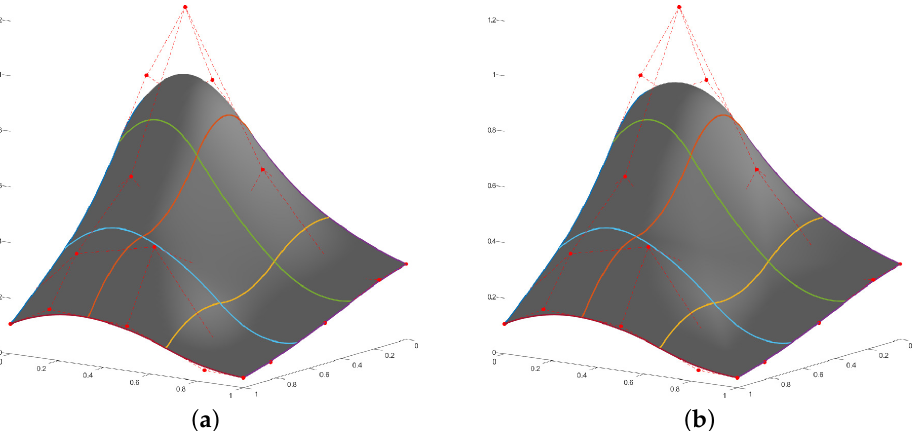
Figure 15. ( a ) Tensor product and ( b ) triangulated surfaces interpolating the curve network in Figure